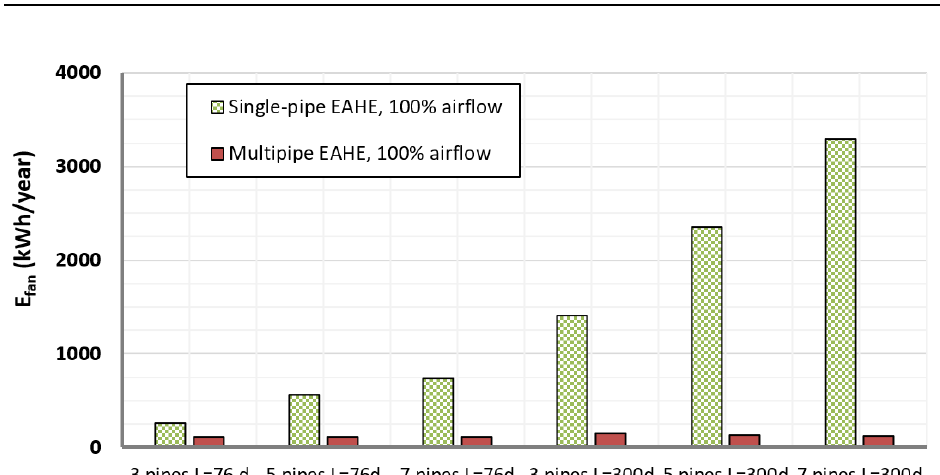
Figure 9. Full-year energy usage for the fan flowing air through the earth-to-air heat exchanger; system usage: 100% of the time at maximum airflow.